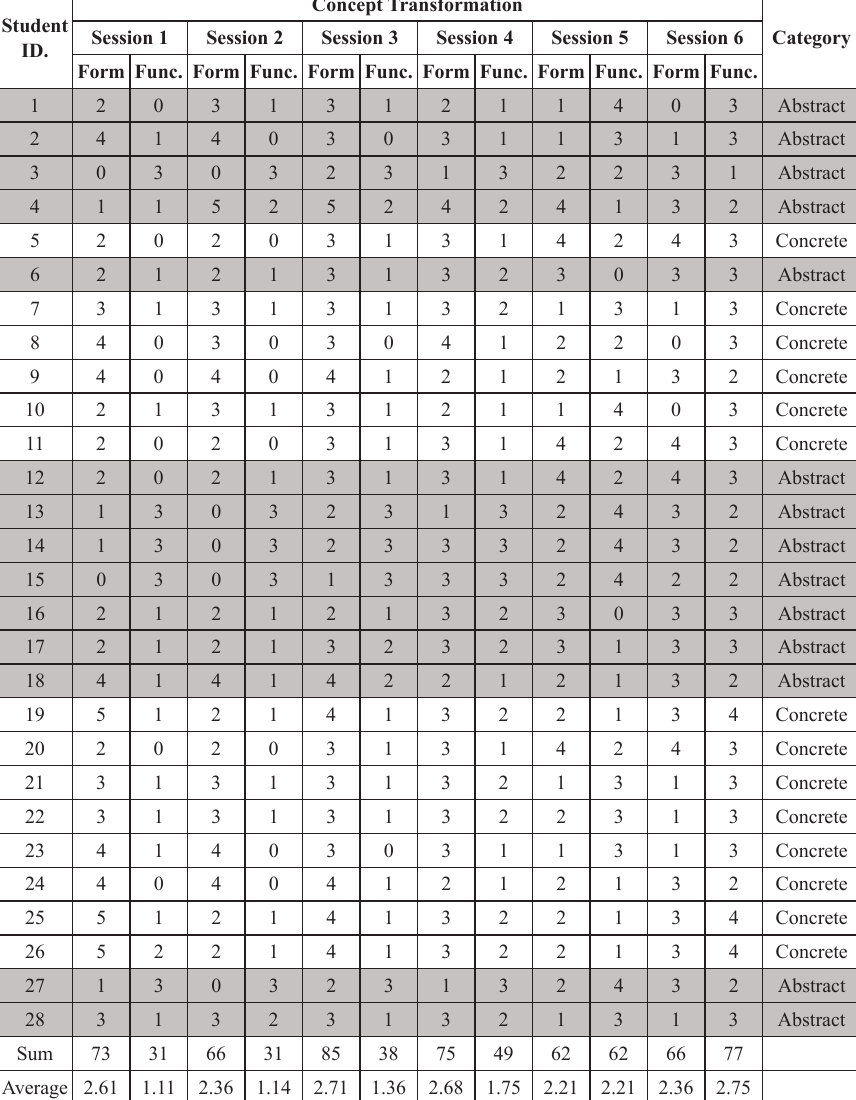
Table 2. Concept transformations during the design sessions Student